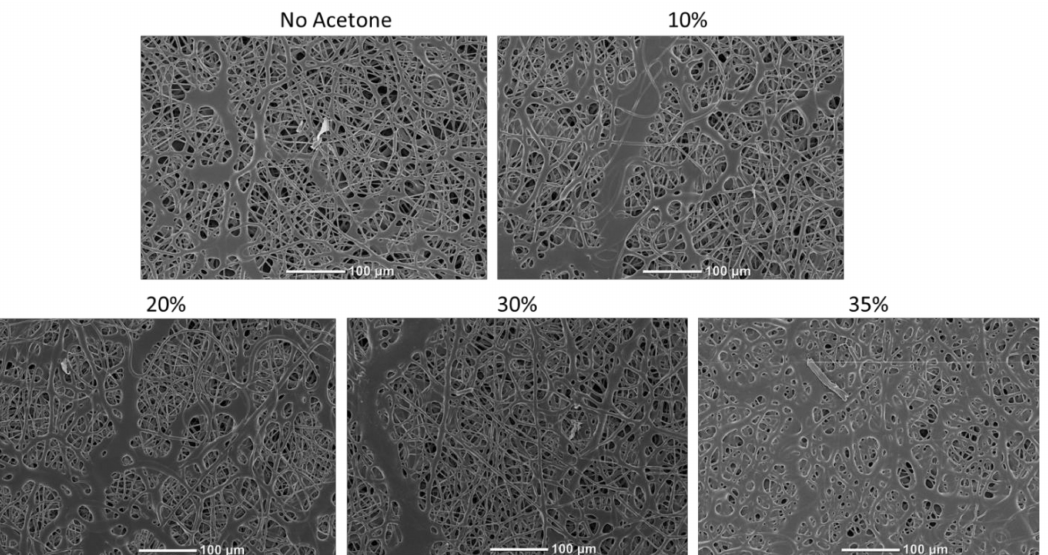
Figure 3. Scanning electron microscopy (SEM) images of electrospin scaffolds which were swollen with varying concentrations of acetone and then dried. Melding of fibers was observed when 35% acetone was used.